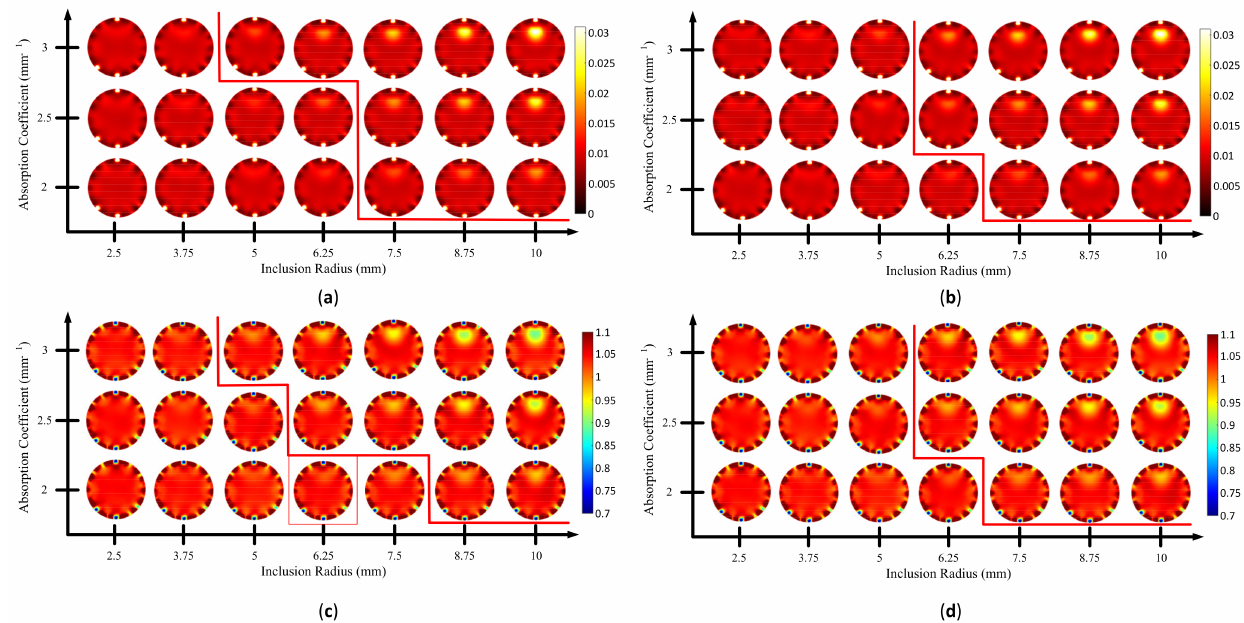
Figure 20. Reconstructed images of case B2 with 10% noise amplitude, phase, and optical properties; red line indicates the invisible ( left side ) and visible ( right side ) inclusions: ( a ) µ a MS-ISSIM-S, ( b ) µ a MOS, ( c ) µ (cid:48) s MS-ISSIM-S, and ( d ) µ (cid:48) s MOS.